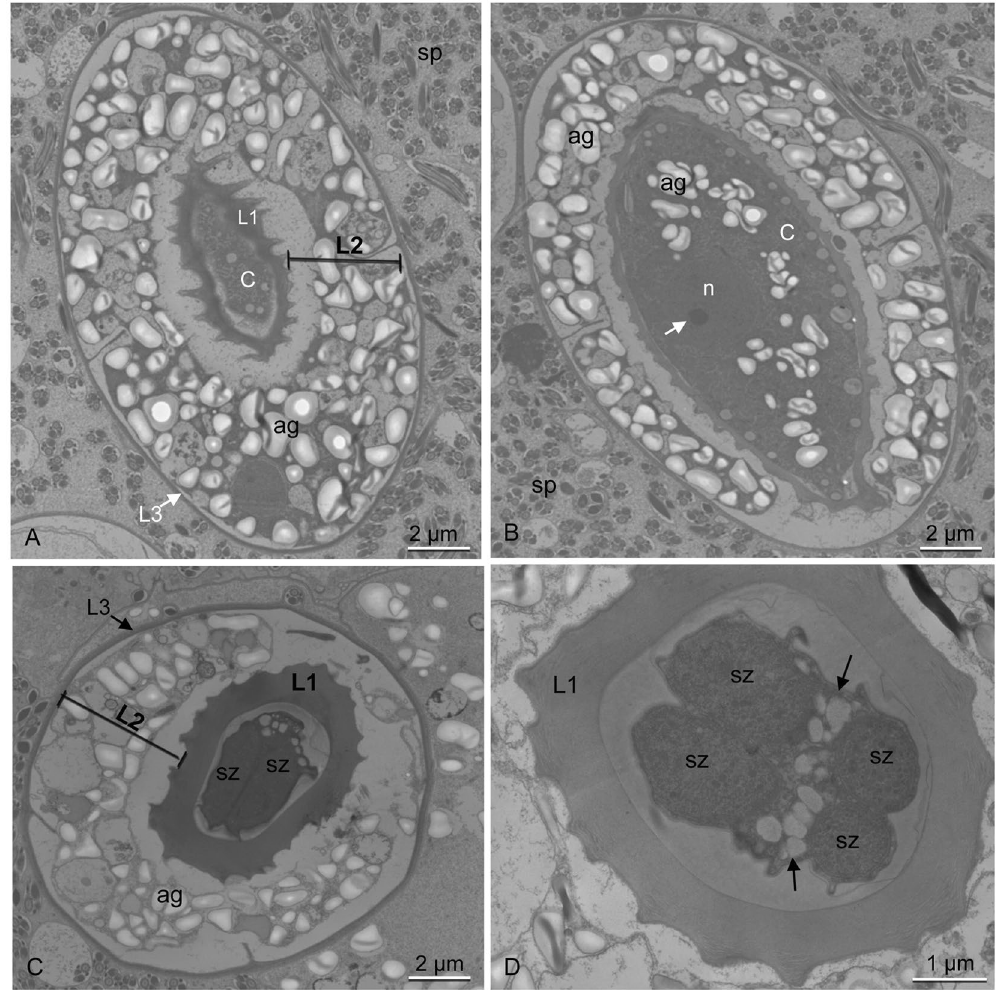
Figure 4. Electron micrographs of oocytes. ( A,B ) Sagittal section of oocytes showing the thick extracellular wall with three layers (L1–L3). In ( B ) note a single sporozoite (sp) showing nucleus (n) and small nucleolus (arrow). Cytoplasm (c); amylopectin granules (ag); spermatozoa (sp). ( C,D ) Transverse section of oocytes showing two ( C ) and four ( D ) sporozoites (sz) linked by cytoplasmic bridges